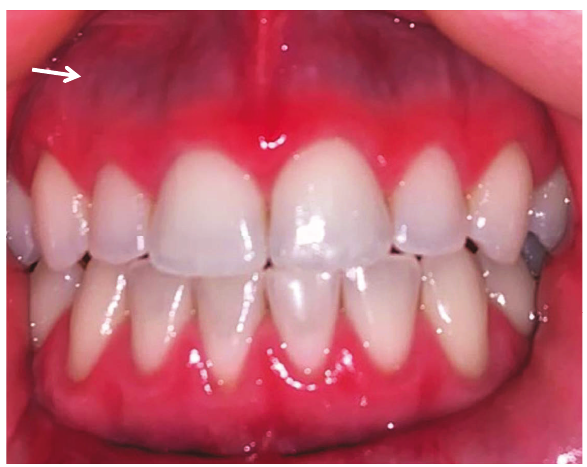
Figure 2: 1.5-year follow-up after discontinuation of minocycline, dark blue pigmentation is found in the maxillary gingival